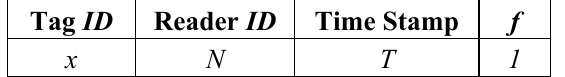
Table 3. Structure of 0intra-cluster node data packet.